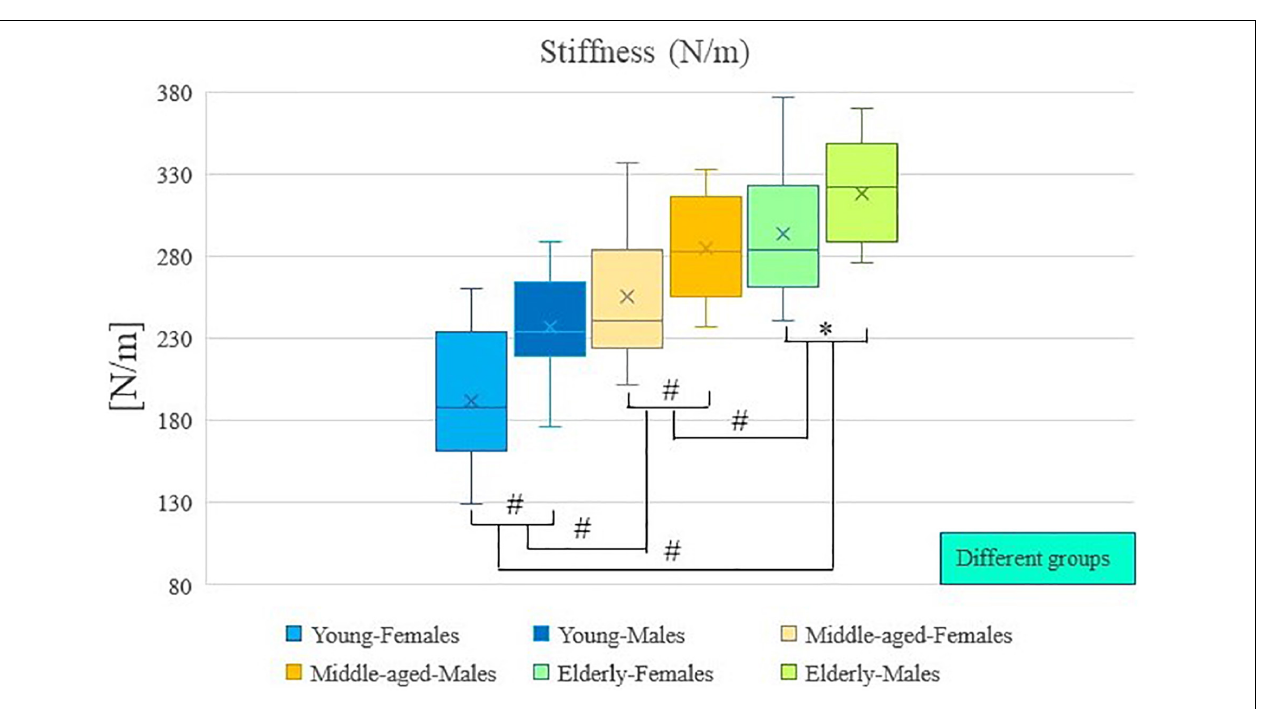
participants ( P < 0.01; Table 4 ). The muscle tone and stiffness of the lumbar erector spinae of male participants were significantly higher than those of females. The Paired Sample T -test showed that in the young group, middle-aged group, and elderly group,